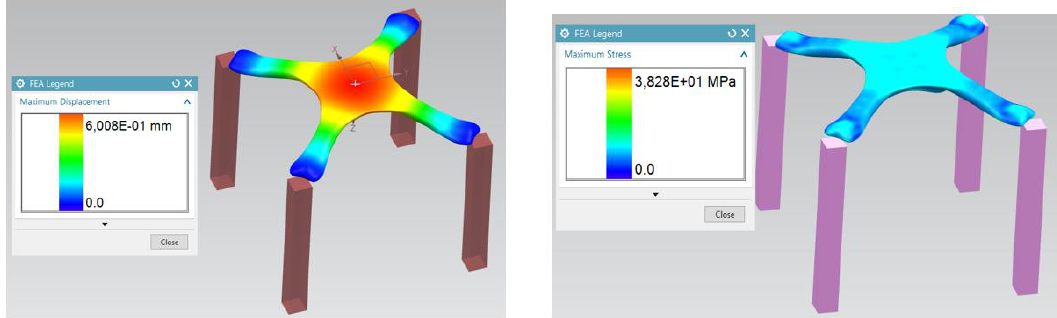
Figure 9. The Maximum Displacement and Maximum Stress of optimized